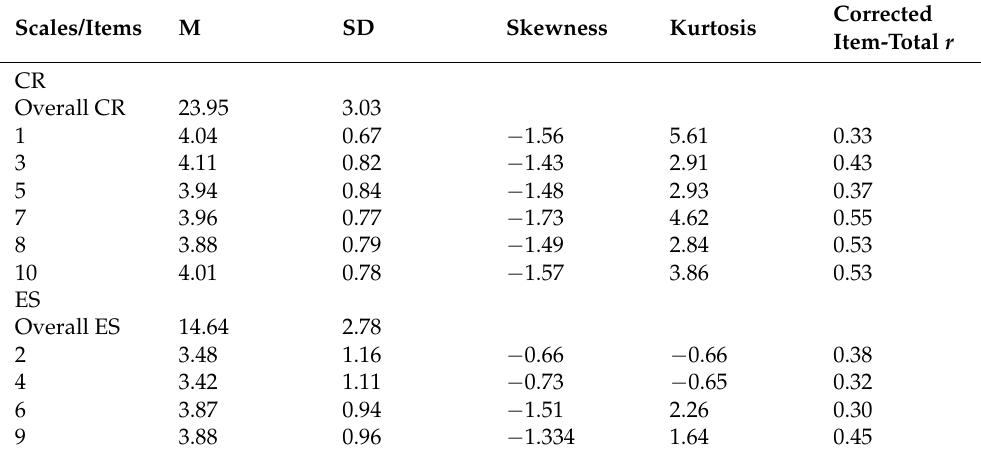
Table 5. Mean (M), standard deviation (SD), skewness, kurtosis, and corrected item-total r for all items of the Malay version of the ERQ-CA in Study